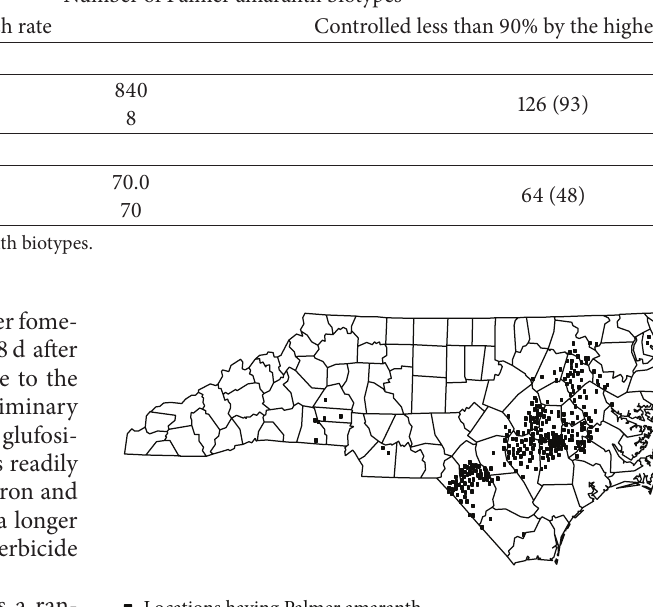
Locations having Palmer amaranth Figure 2: Distribution of Palmer amaranth in 2005 survey, adapted from Whitaker